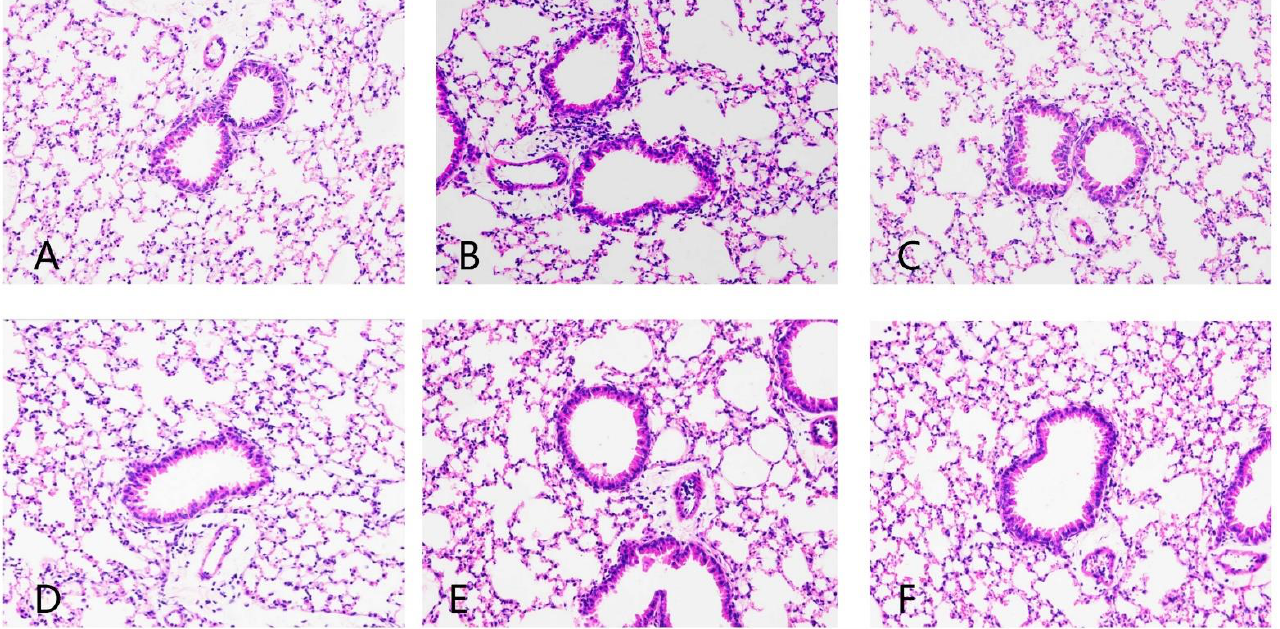
Figure 5. The effects of ECP and ECT on lung histopathology in mice with eCS exposure-induced lung injury (200 × ). ( A ): Control; ( B ): eCS; ( C ): eCS + ECP T; ( D ): eCS + ECT T; ( E ): eCS + ECP P; ( F ): eCS + ECT P.